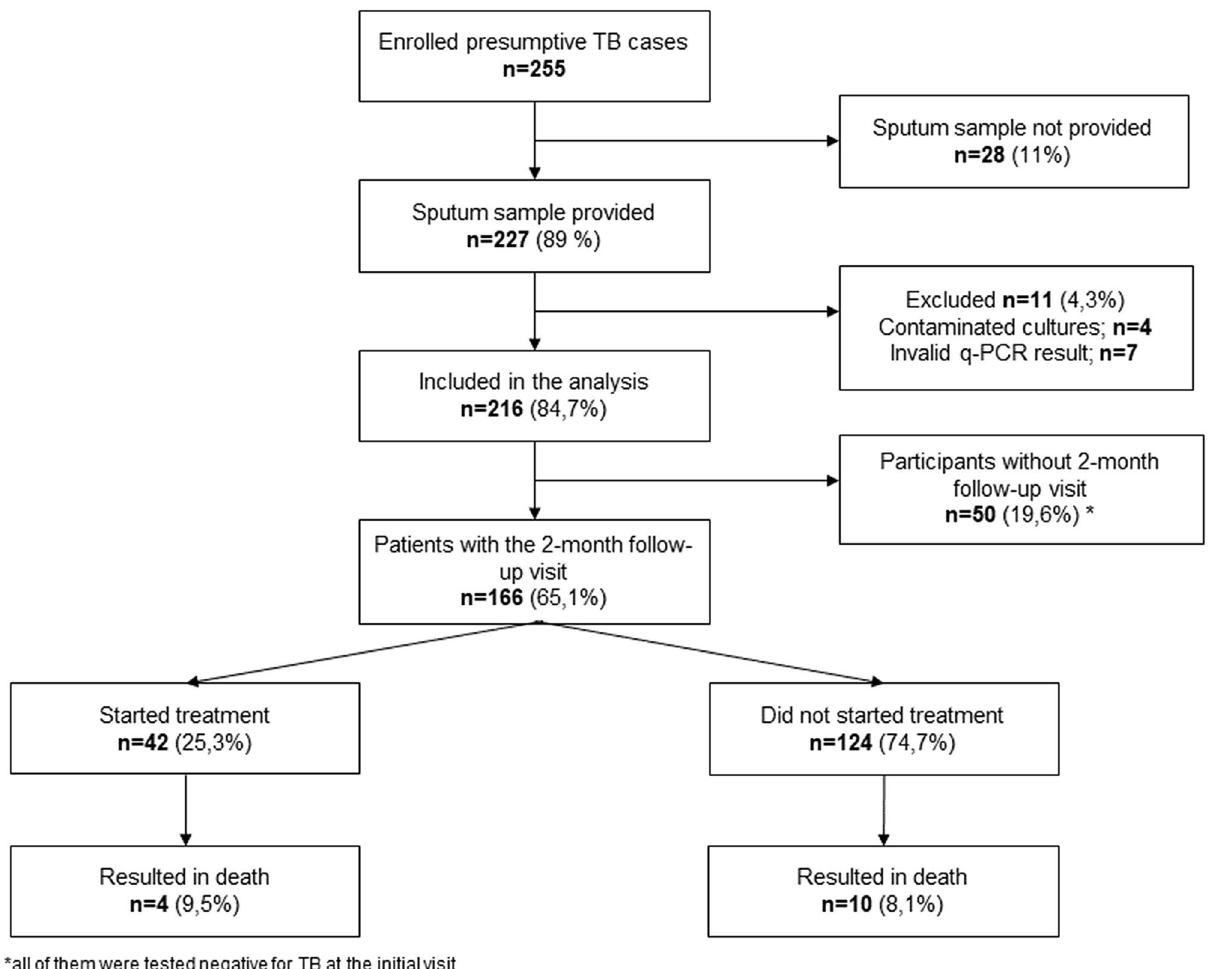
Figure 2. Participant enrolment flowchart. *Participants tested negative for TB at the initial